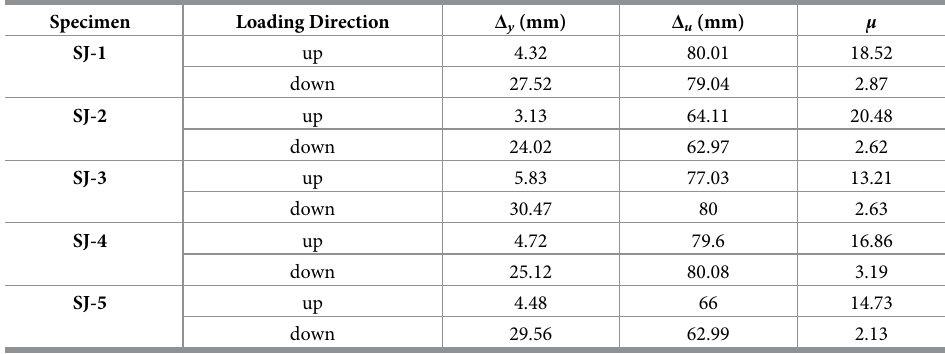
Table 4. Ductility of the five